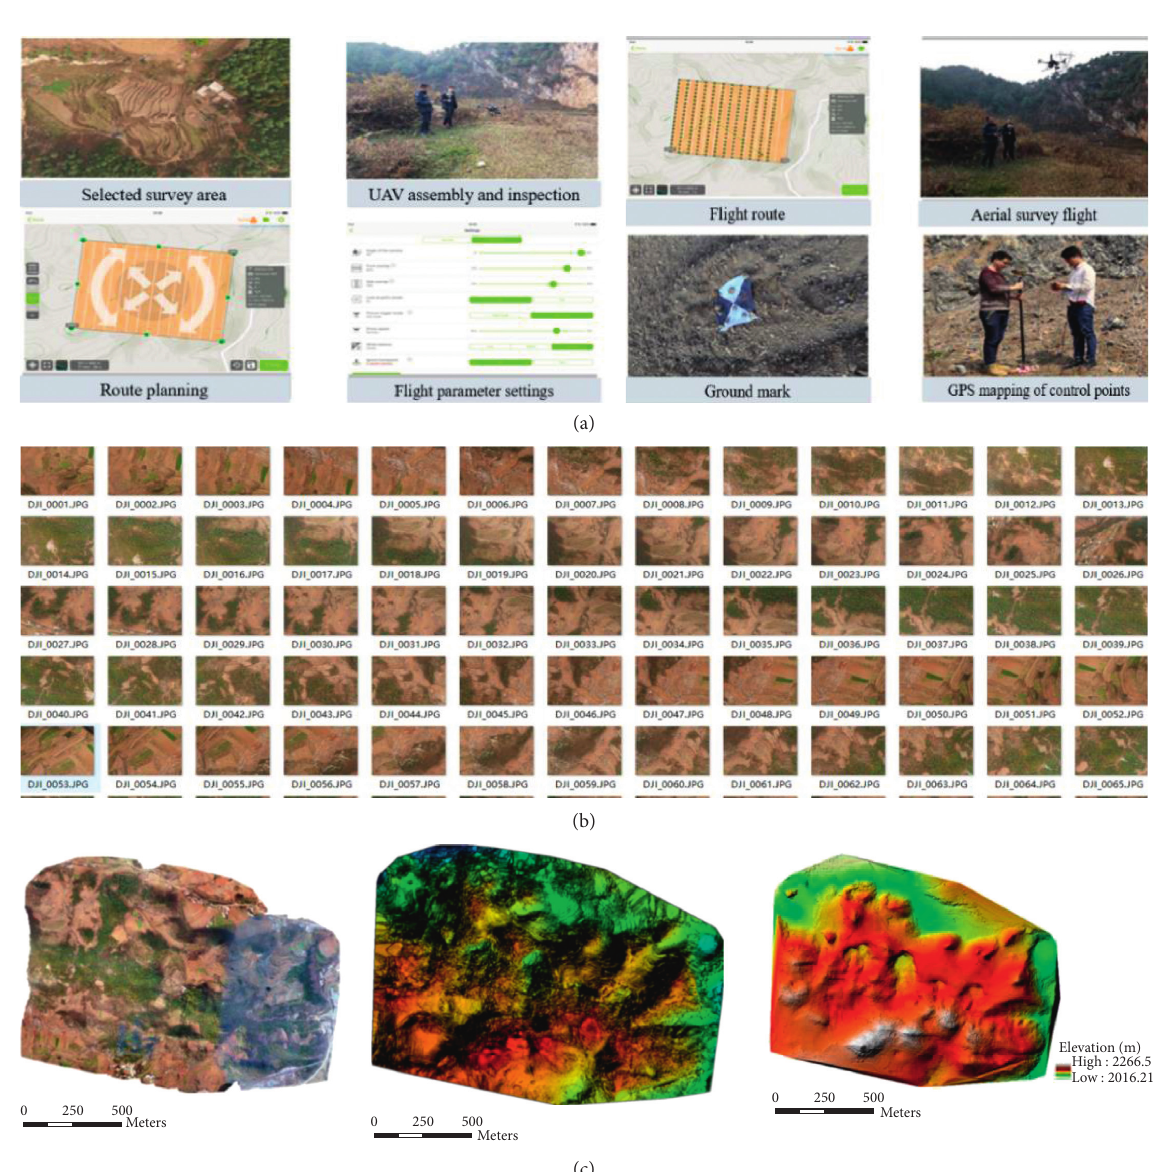
Figure 5: Digital terrain results: (a) workflow of UAV photogrammetry; (b) partial orthographic images; (c) DOM, DSM, and DEM